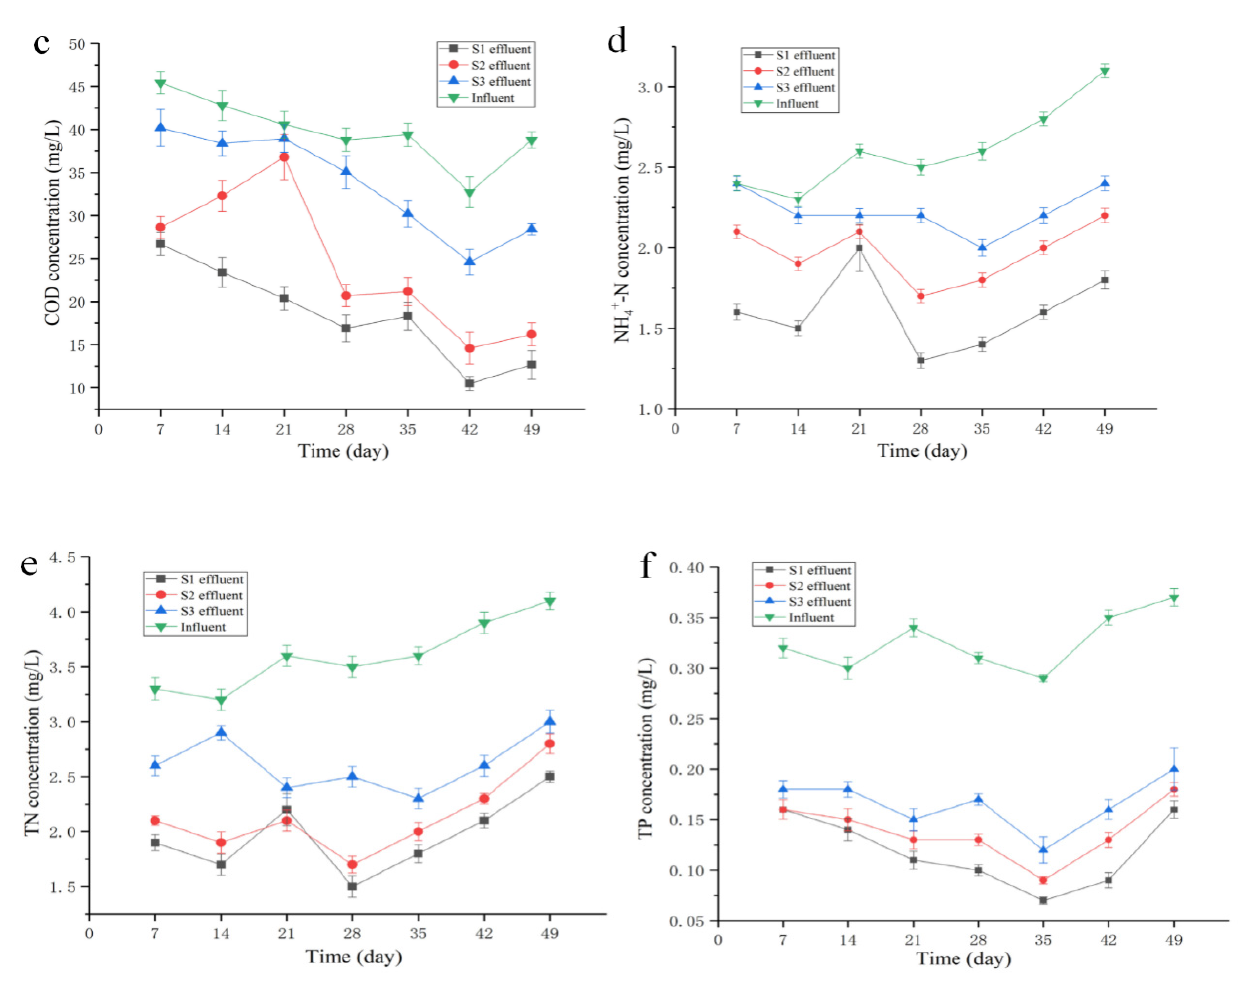
Figure 4. Influent and effluent temperature in S1–S3 ( a ); influent and effluent pH in S1–S3 ( b ); influent and effluent COD concentrations in S1–S3 ( c ); influent and effluent NH 4+ -N concentrations in S1–S3 ( d ); influent and effluent TN concentrations in S1–S3 ( e ); influent and effluent TP concentrations in S1–S3 ( f ).